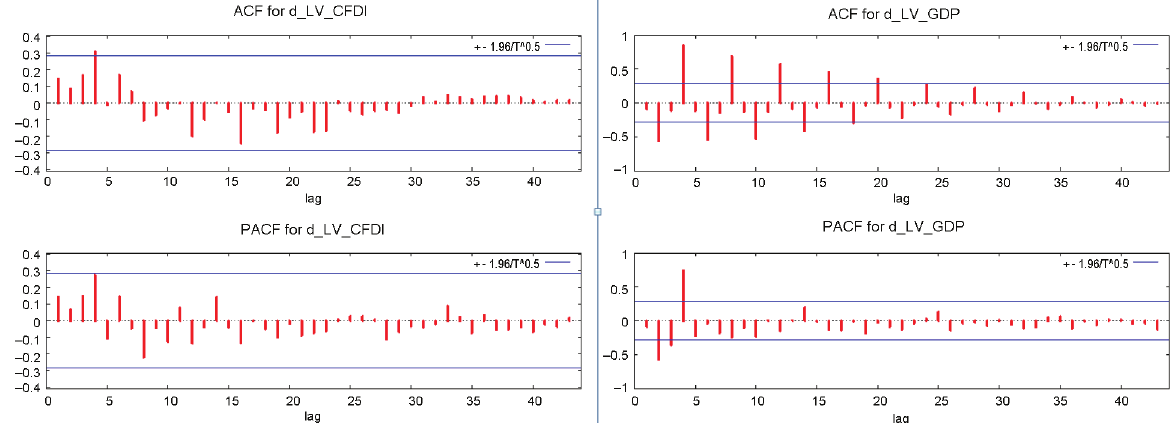
Fig. 12. Time series plots of the first-order integration autocorrelation function (ACF) and partial autocorrelation function (PACF) for Latvia’s CFDI and the construction’s contribution to GDP